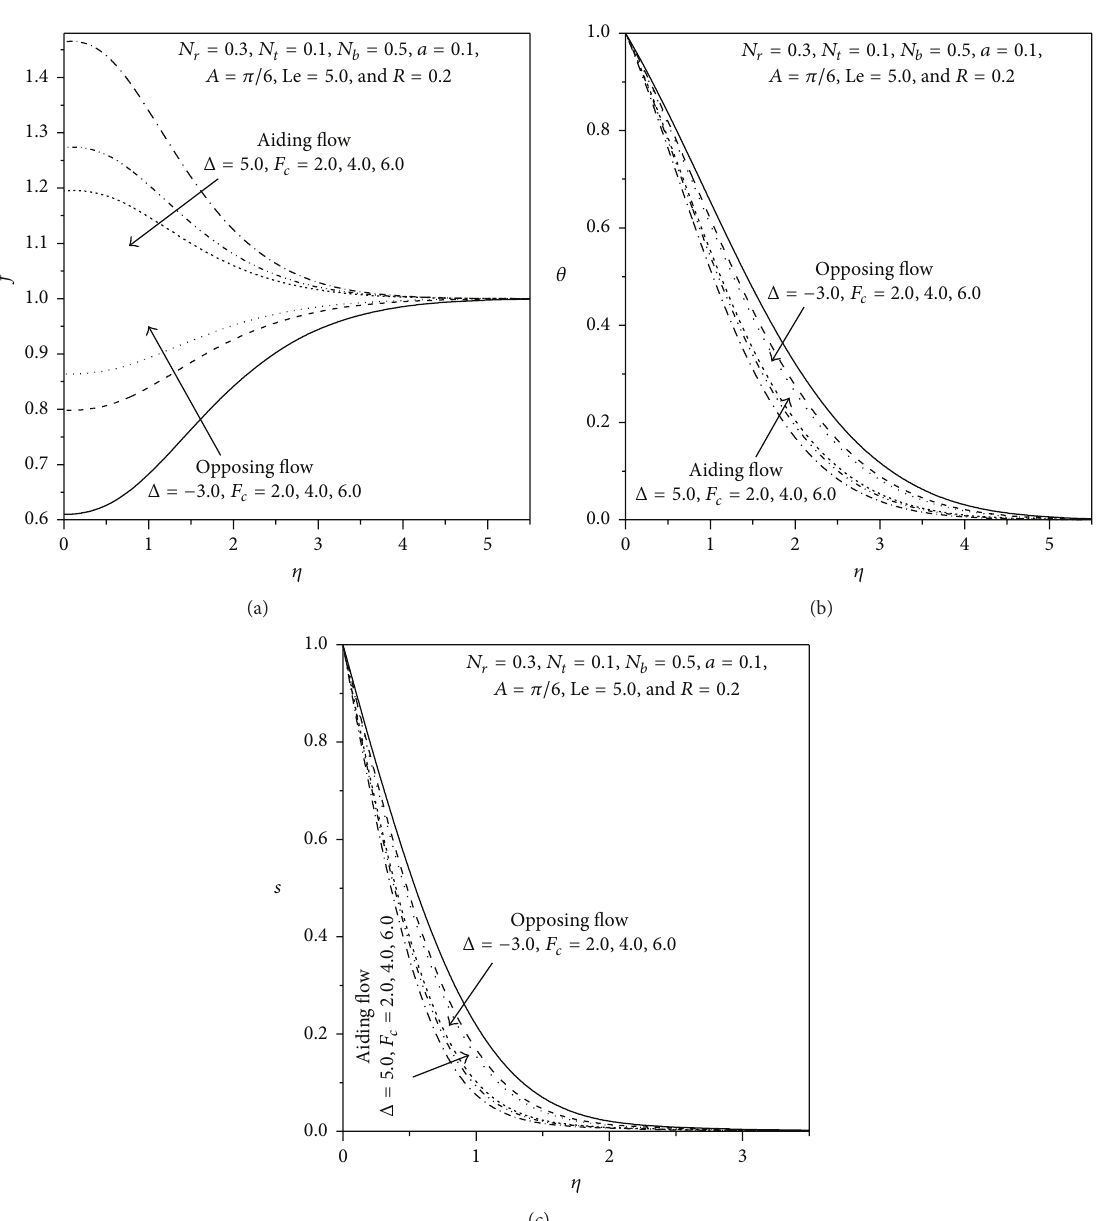
increase in 𝐹 𝑐 decreases the temperature for opposing